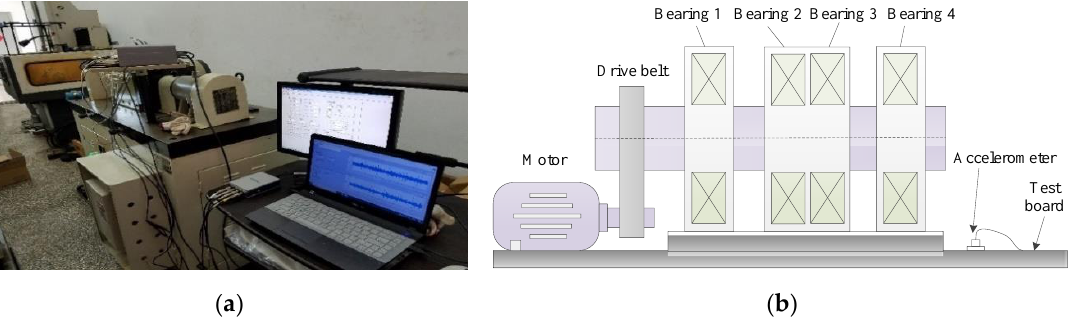
Figure 9. ( a ) Photo of experimental equipment and ( b ) its corresponding structure diagram.